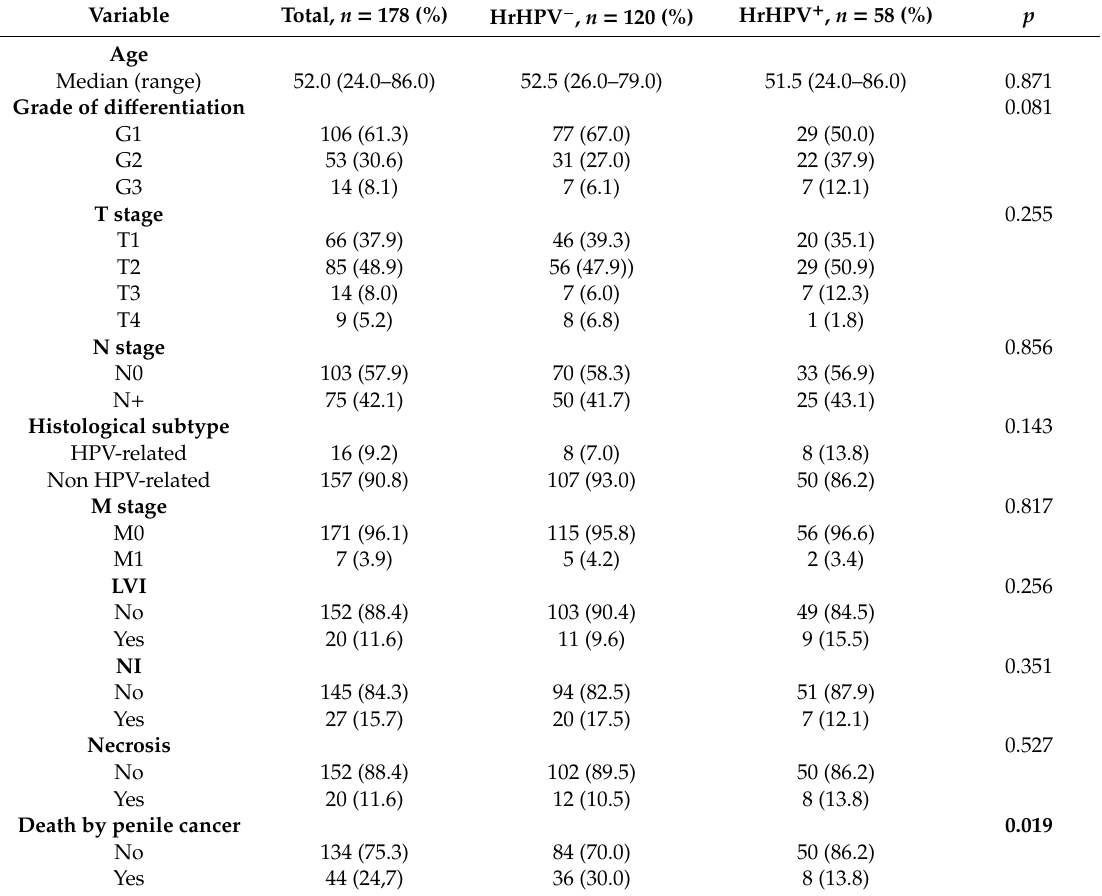
Table 1. Clinicopathological characteristics associated with hrHPV